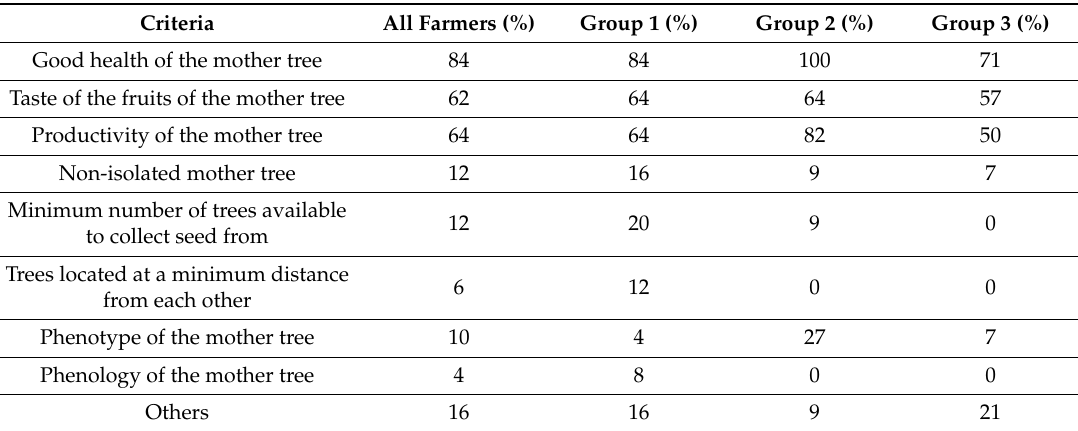
Table 6. Criteria for choosing mother trees based on the number of citations of each criteria by farmers directly involved in seed collection, in each of the three different farmers’ groups. More than one criteria could be mentioned, so the total in each column is more than 100%. Others = ripeness of the fruits, shape of the fruits, similarity of soils conditions with planting sites. Group 1 = farmers with fences; Group 2 = farmers without fences, in the same villages as Group 1; Group 3 = farmers without fences, in different villages from Group 1 and 2.